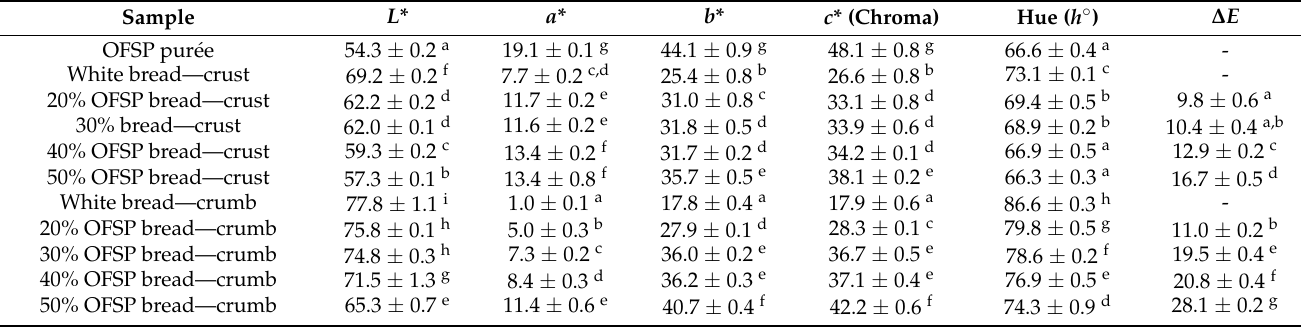
Table 5. Color of OFSP pur é e and processed OFSP pur é e–wheat flour composite bread 1